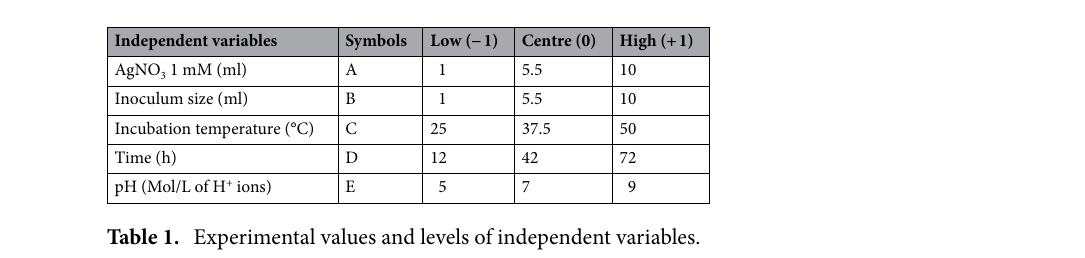
Table 1. Experimental values and levels of independent variables.